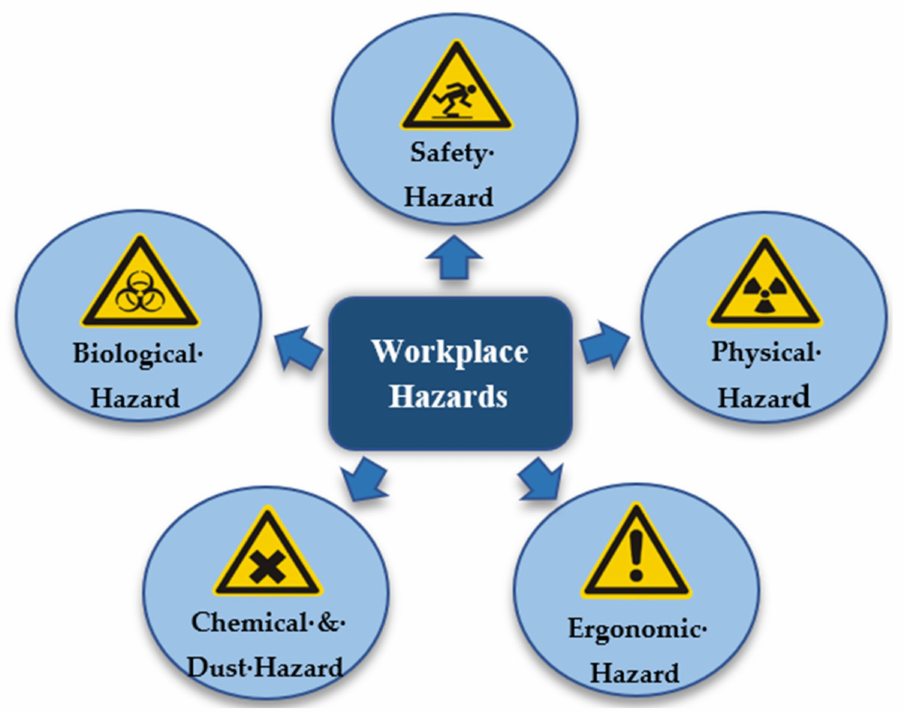
Figure 1. The five main hazards involve in workplaces.